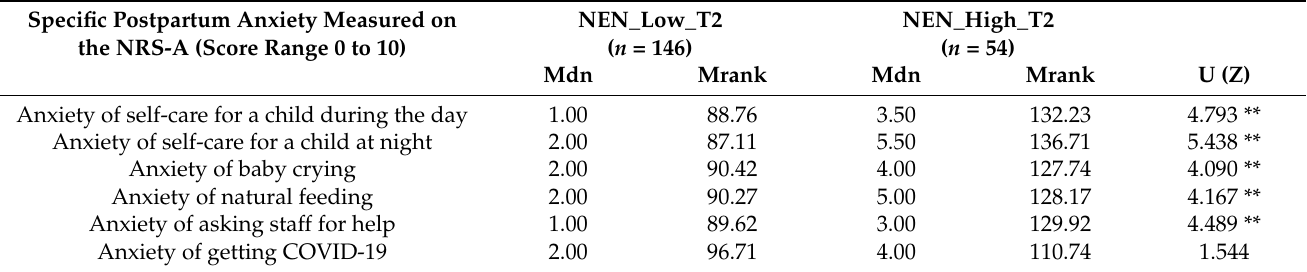
Table 5. Comparison of specific postpartum anxiety between women who felt NEN and those who do not.